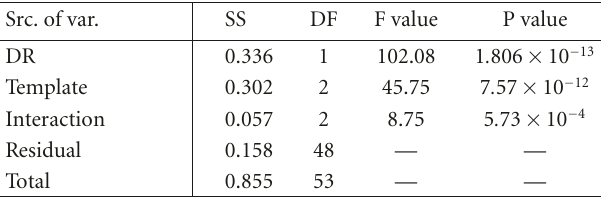
Table 11: Results of McNemar’s test for full-set and subset tem-